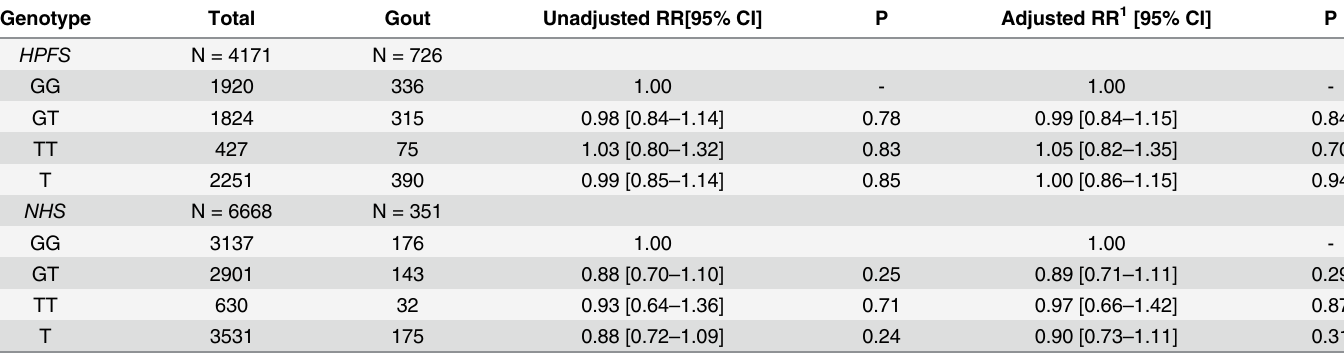
Table 3. Rs2149356 genotype and association with risk of gout in the HPFS and NHS sample sets.